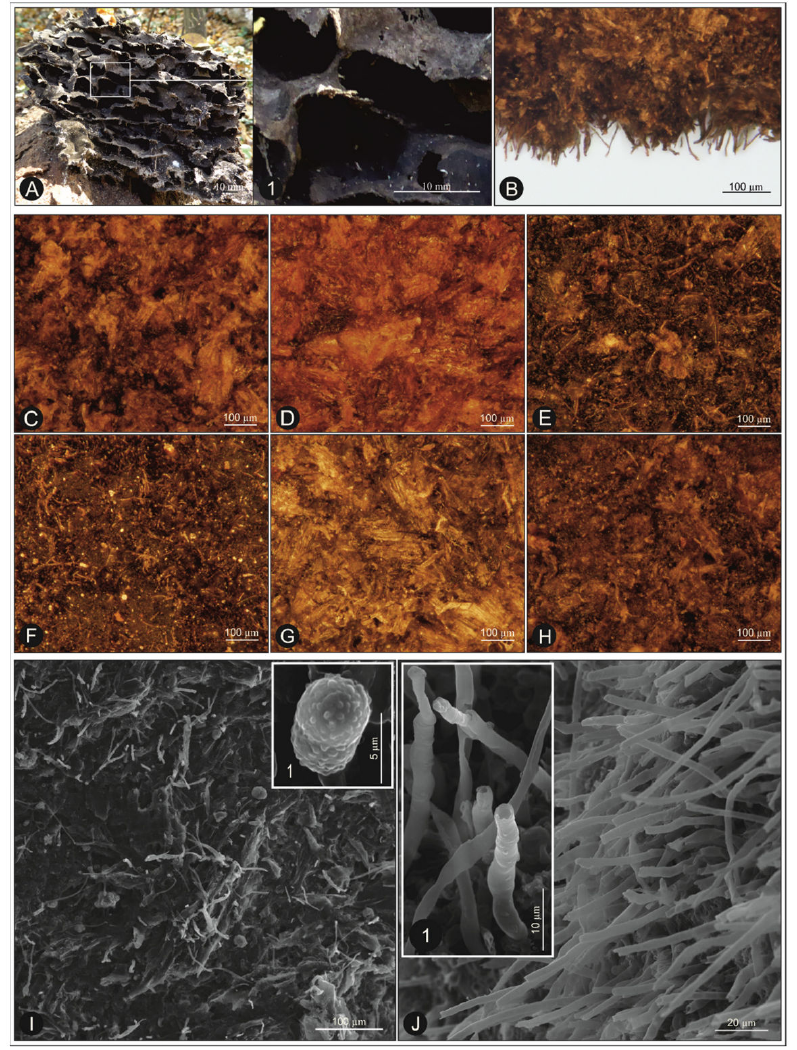
Figure 1. The carton nest taken out of the hollow in the field (forest near Długie Lake, Polesie National Park, Poland) ( A ); macrophotography of the chambers in the nest ( A1 ); the edge of carton with visible fungal structures ( B ); structure of carton from different nests which were the basis of extracts E1–6 ( C – H , respectively); microstructure of carton ( I , J ) with spores; ( I1 ) and fungal structures ( J1 ) (phot. ( A – H ): G. K. Wagner; phot. ( I , J ): B.